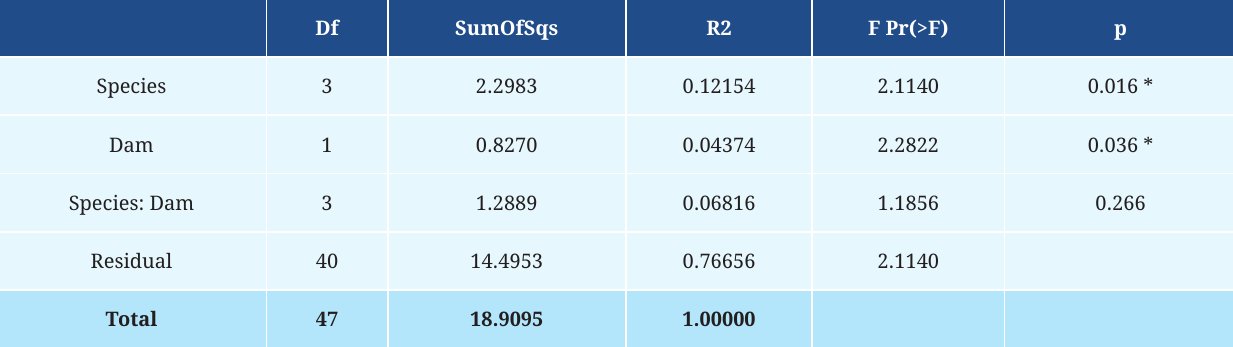
TABLE 3 | Permutational Multivariate Analysis of Variance (PERMANOVA) applied to percent volume of the diet of four piscivorous fishes from Madeira River before and after damming. Significant p-values are indicated by